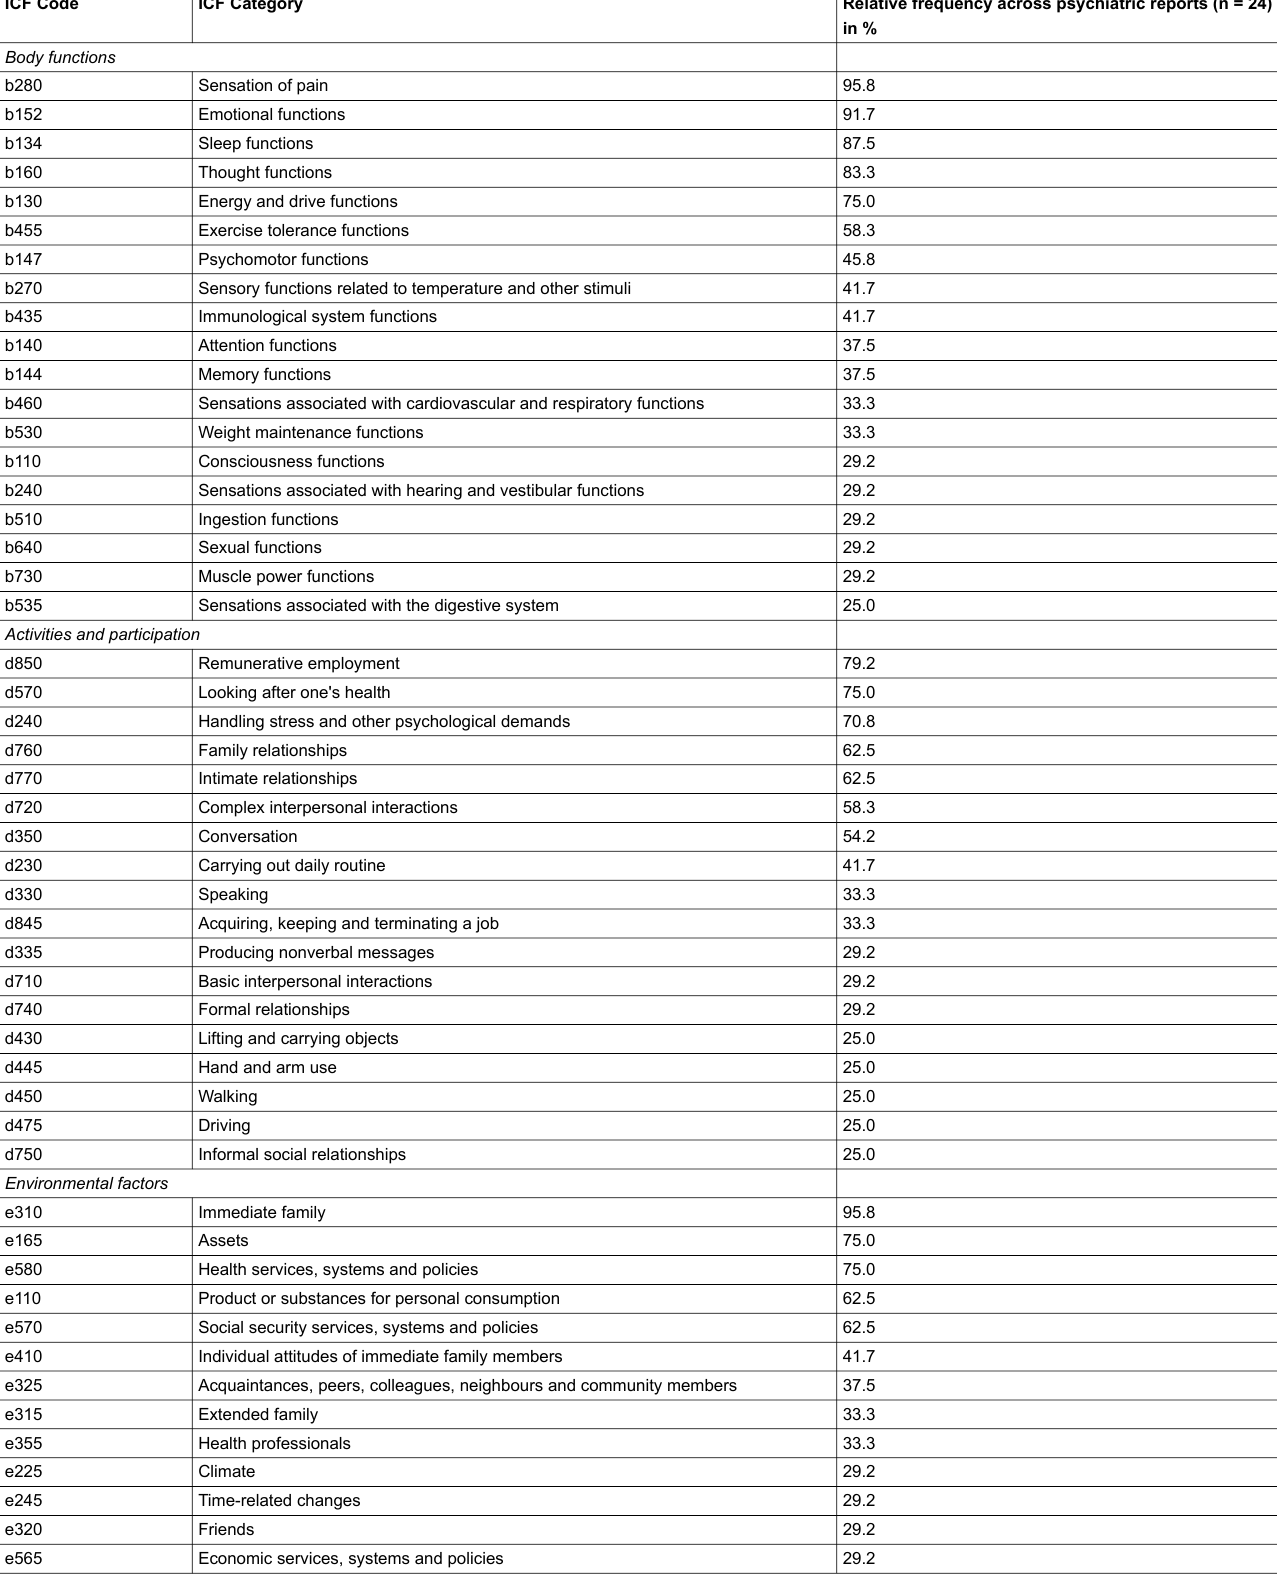
Table 4: Second level candidate categories referring to ICF body functions (b), activities and participation (d), environmental factors (e), personal factors (i) and specification categories. ICF